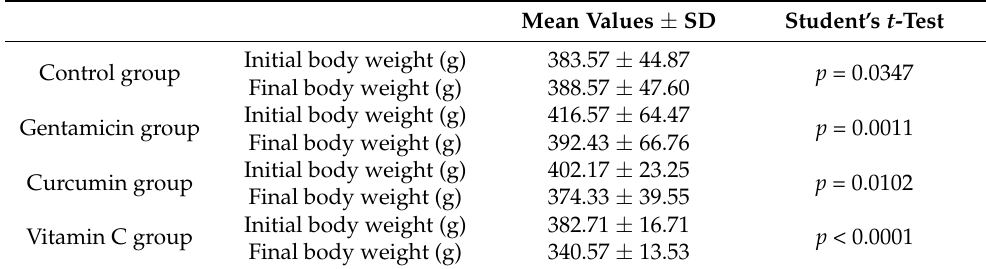
Table 1. Weight of the animals included in the